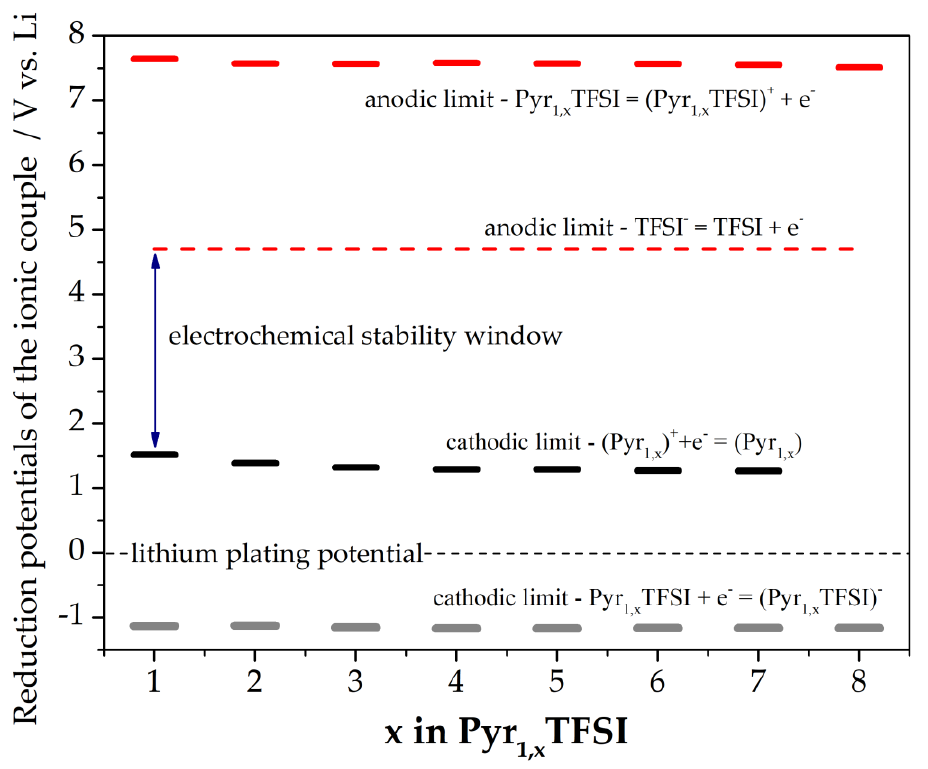
Figure 3. Predicted electrochemical stability windows for the Pyr 1,x TFSI (x=1-8) ionic liquids.